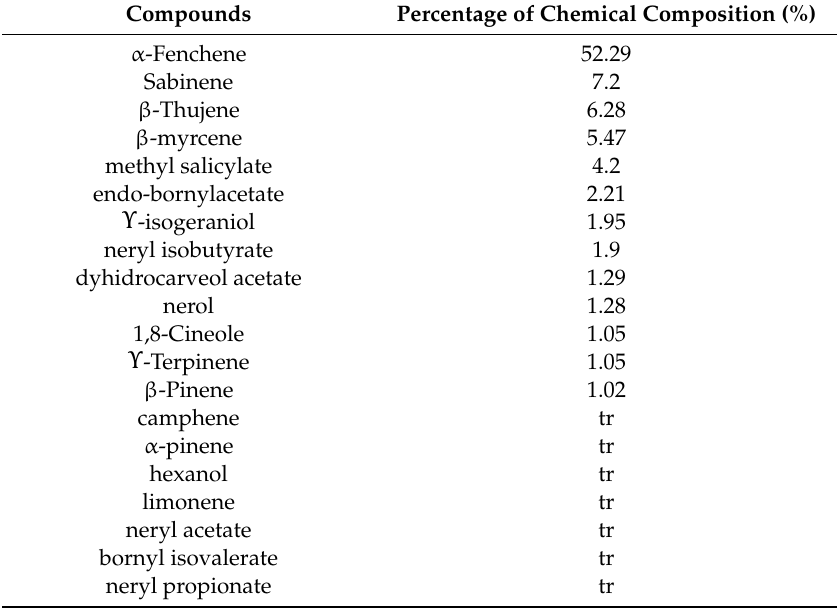
Table 1. Chemical composition of wormwood essential oils (WW EOs) obtained from dried root parts of Arthemisia absinthium L.